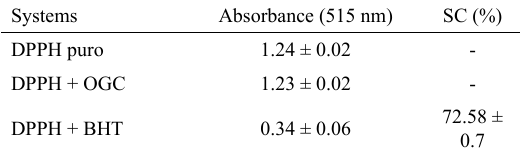
Table 2. Radical DPPH scavenging capacity (SC) results Systems Absorbance (515 nm)